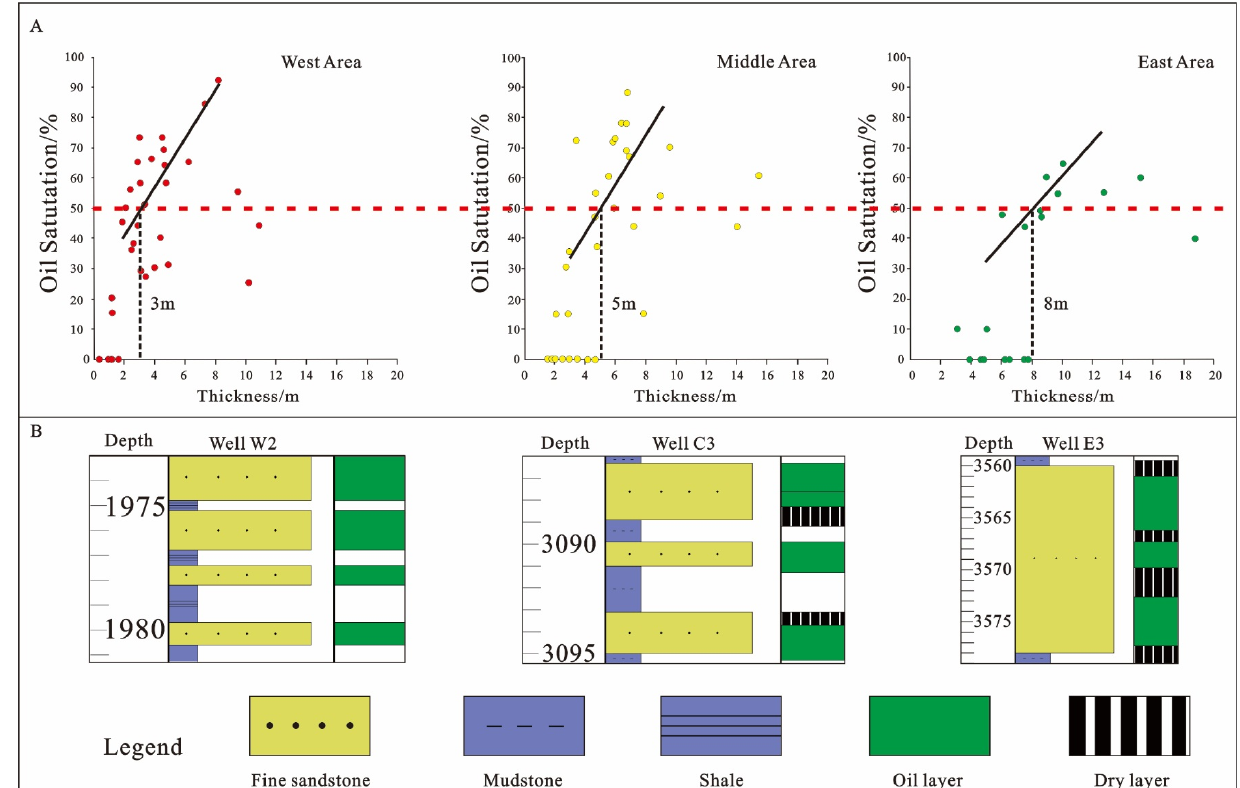
Figure 12. ( A ) Statistical relationship between critical sandstone thickness and oil saturation in different areas of the northern steep-slope zone of the Weixinan Sag. ( B ) Sandstone thickness and oil–gas bearing analysis of typical well logging in different areas.